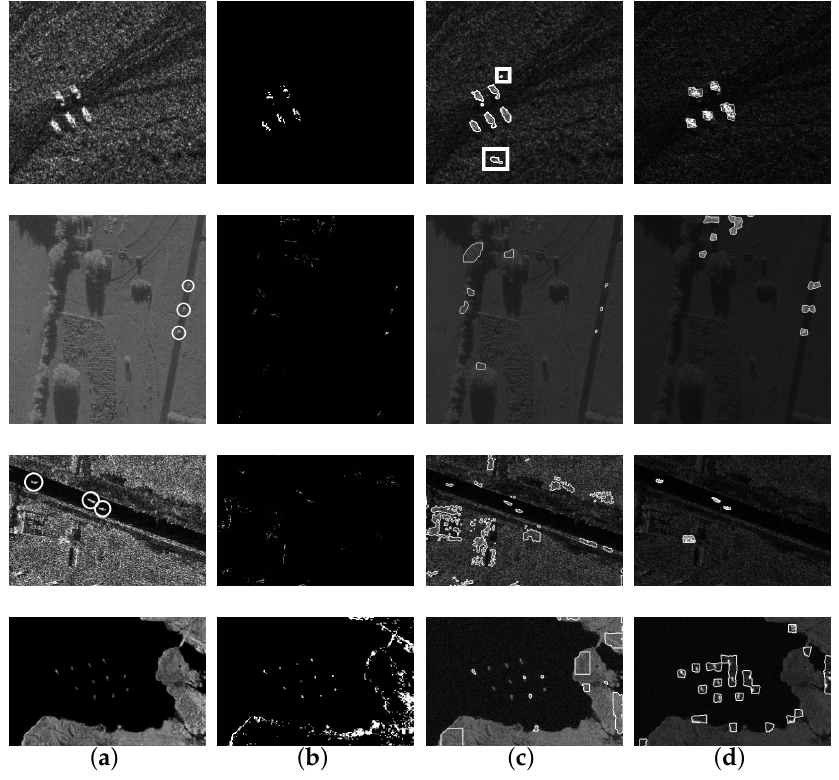
Figure 9. Comparison of SAR image target detection results. ( a ) Original SAR image; ( b ) G 0 -CFAR; ( c ) WIE; ( d ) Our algorithm.